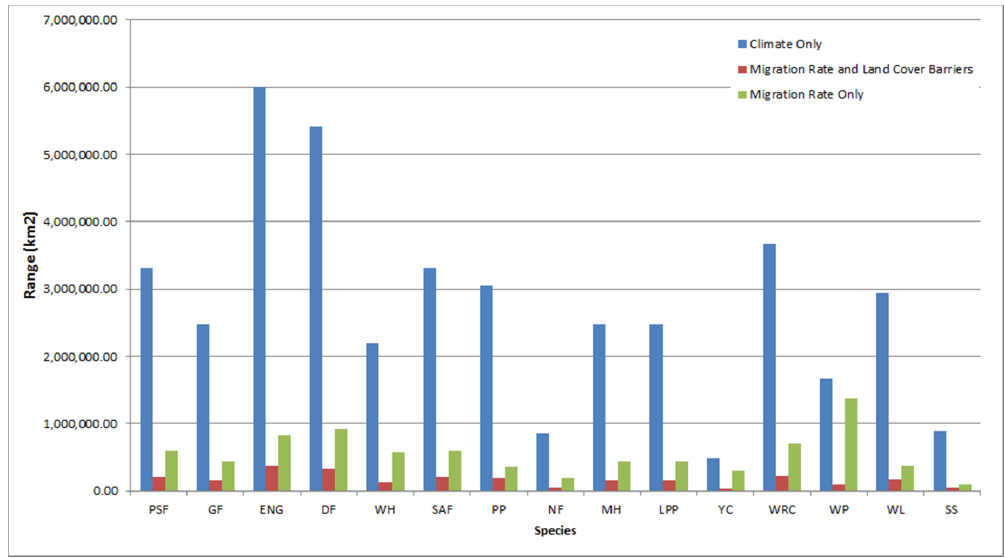
Figure 6. Species ranges (km 2 and % difference from current distribution) predicted by 2080 using realistic migration rates (maximum of 200 km or m/year) and with barriers imposed by land cover and topography. Species abbreviations: Pacific silver fir (PSF), grand fir (GF), Douglas-fir (DF), western hemlock (WH), subalpine fir (SAF), ponderosa pine (PP), noble fir (NF), mountain hemlock (MH), lodgepole pine (LLP), Alaska yellow-cedar (YC), western redcedar (WRC), western white pine (WP), western larch (WL) and Sitka spruce (SS).